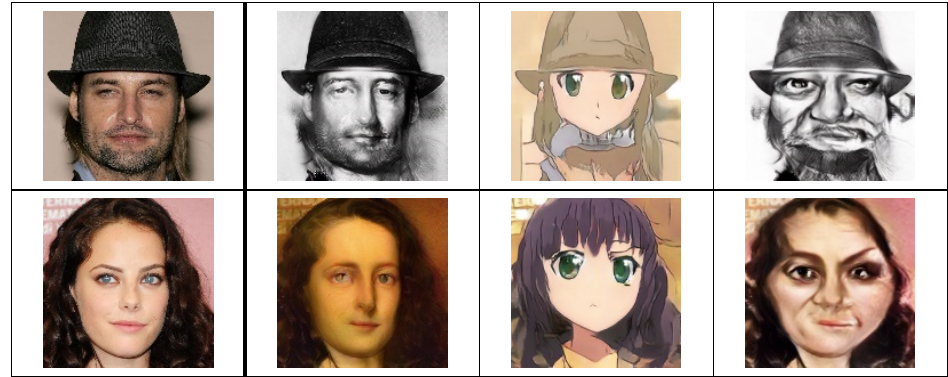
Figure 4. Visualizing conditional artistic face translation using the trained Multi-CartoonGAN.